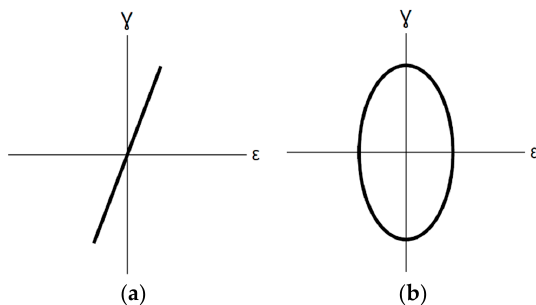
Figure 2. Schematic of the loading paths studied. In-phase ( a ) and out-of-phase load path ( b ).